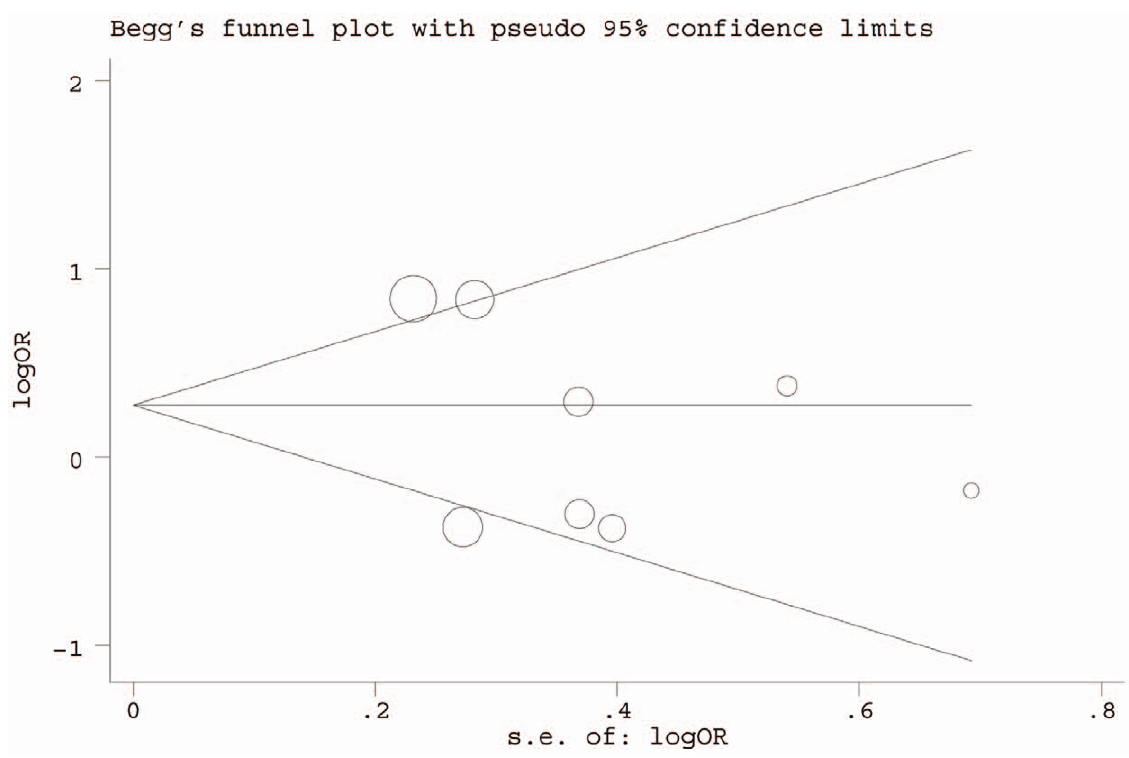
Figure 5. For XRCC1 Arg399Gln polymorphism, Begg’s funnel plot for publication bias test. (Gln/Gln vs. Arg/Arg). Each point represents a separate study for the indicated association. LogOR, natural logarithm of OR. Horizontal line, mean effect size.